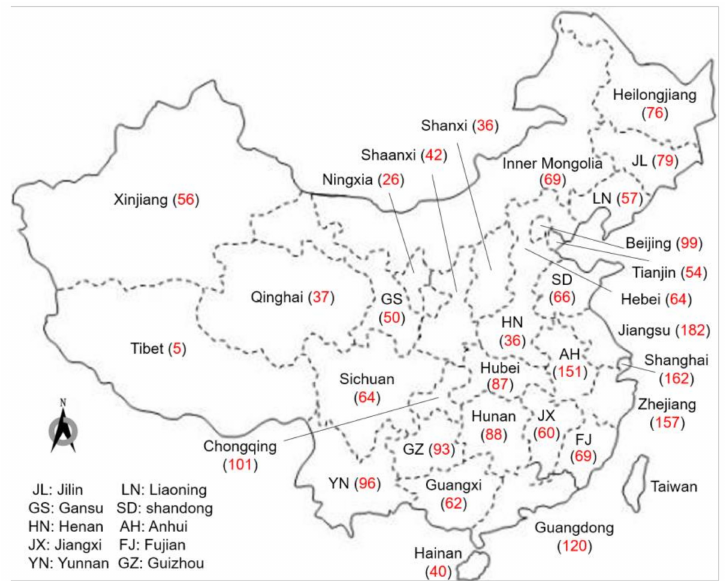
Figure 2. The geographic distribution of construction accidents in provinces